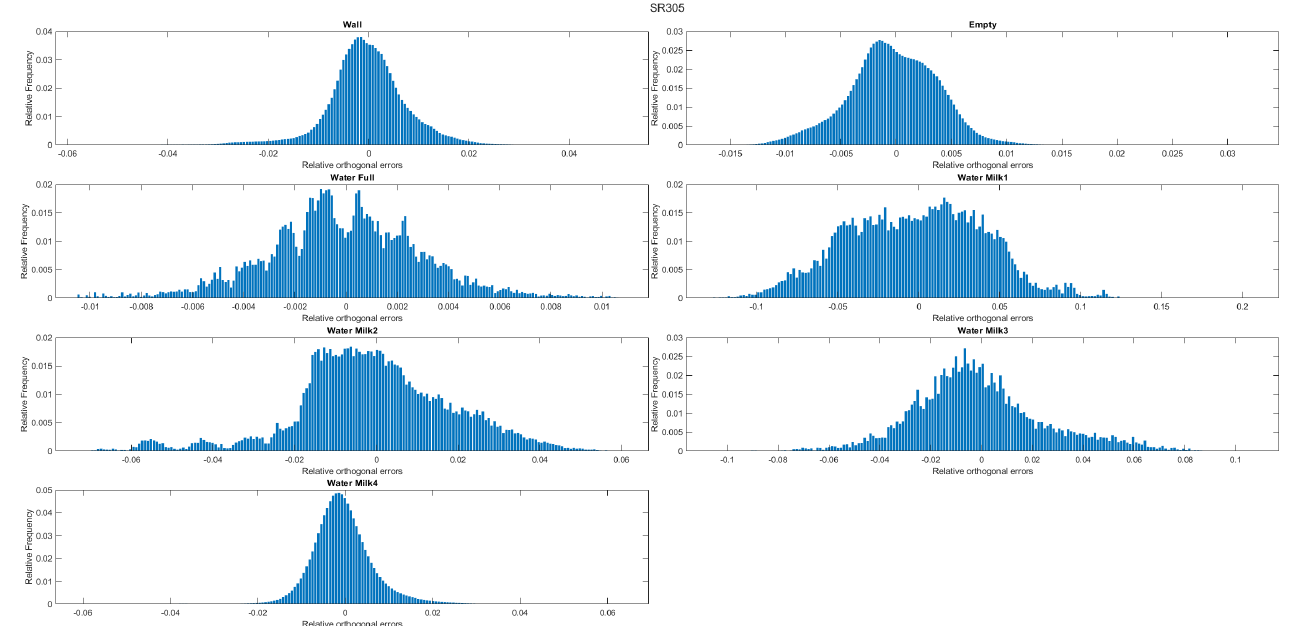
Figure 17. Histogram of orthogonal distances for the SR305